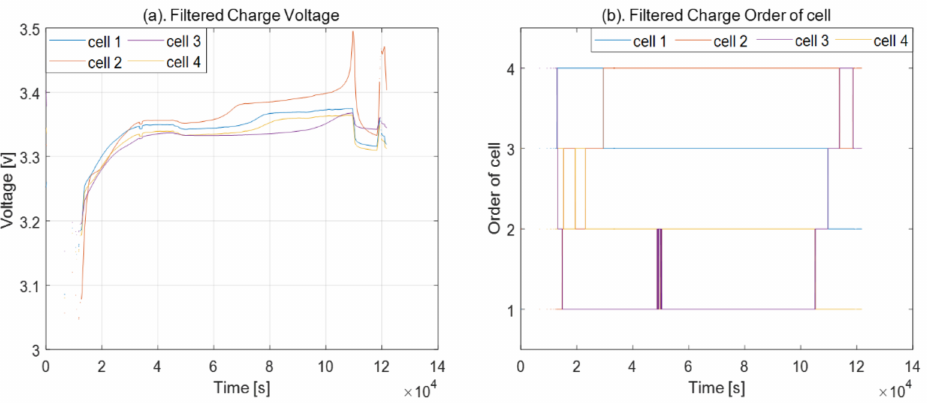
Figure 17. Resistance problem (( a ) filtering the charge part in Figure 15 (left), and ( b ) order of cell